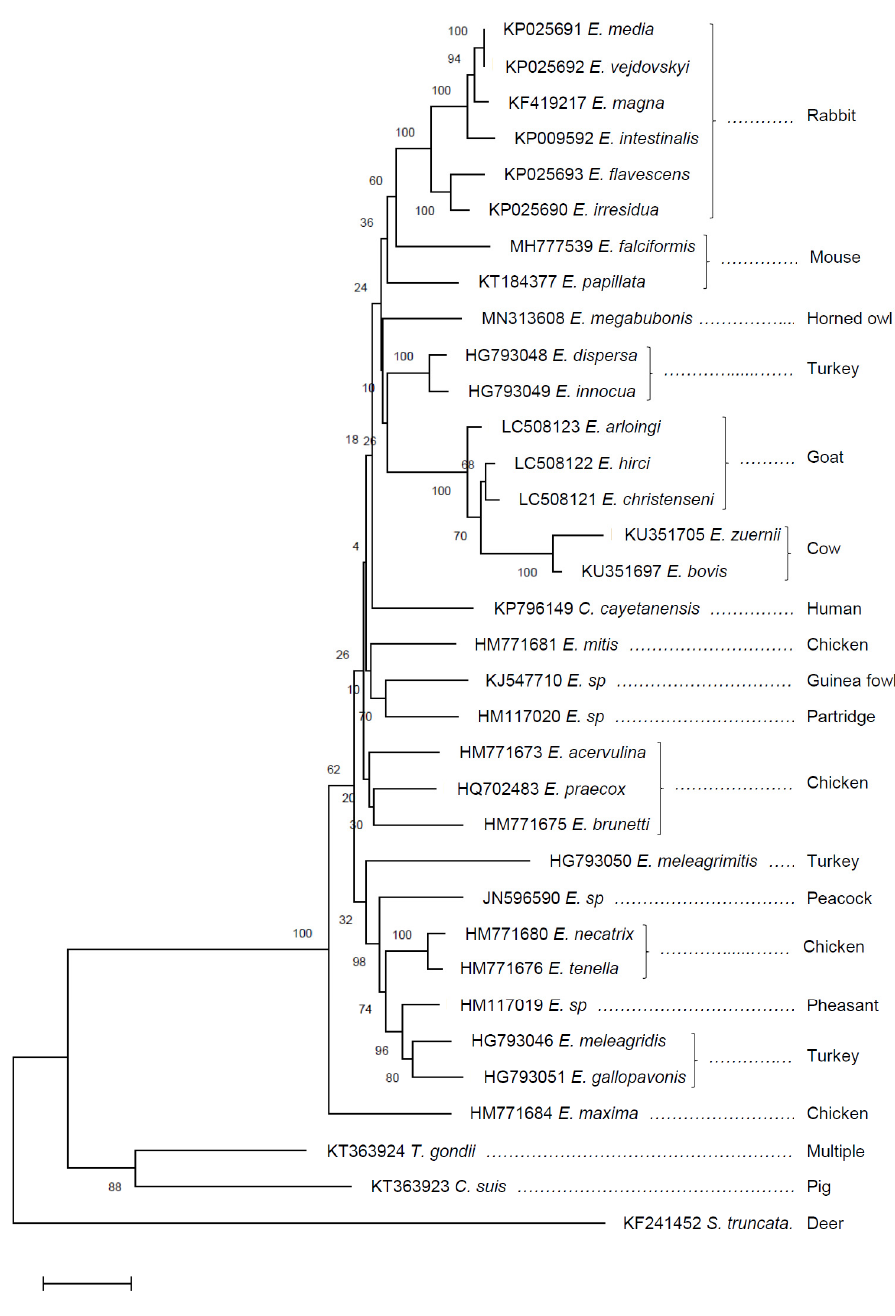
Figure 1. Neighbor joining phylogeny of partial coccidian mitochondrial cytochrome c oxidase subunit I (COI) sequences. The optimal tree is shown with the percentage of replicate trees in which the associated taxa clustered together in the bootstrap test (1000 replicates) indicated next to the branches. GenBank accession numbers are shown for each sequence, followed by the parasite species and host (common name) identity. Sequences were aligned using CLC Main Workbench (version 8.0.1), creating a 788 bp alignment. The phylogeny was inferred using MEGA X [56], with the evolutionary distances computed using the Kimura 2-parameter